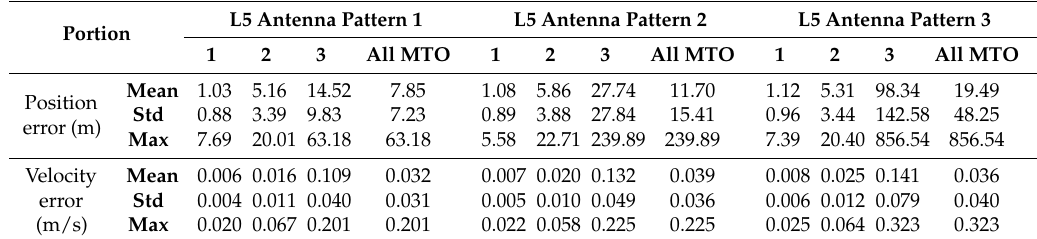
Table 8. Statistics of the range-based orbital filter estimation